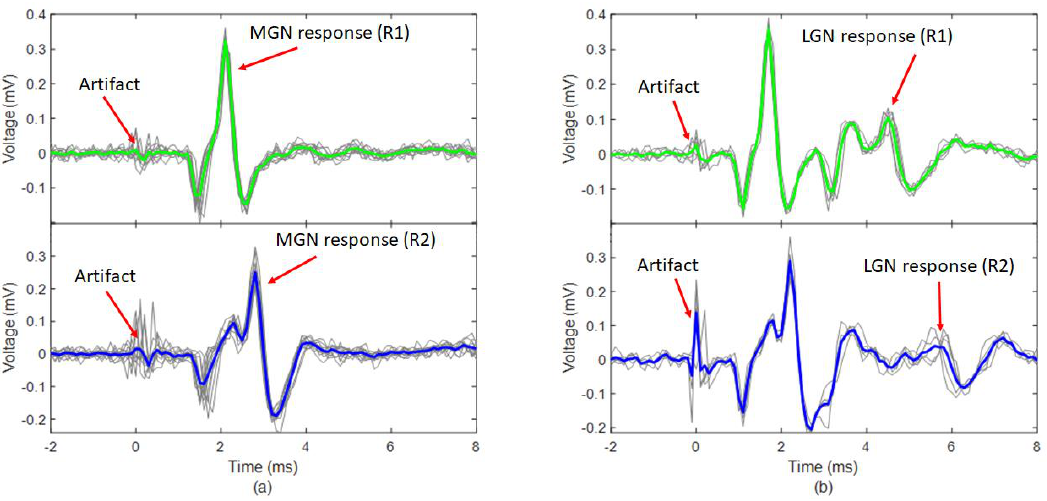
Figure 14. Nerve spikes in response to monophasic current stimulation of a 100 µ s duration recorded from R1 and R2 with amplitude swept from ( a ) 200 to 650 µ A and ( b ) 700 µ A to 2 mA. Recordings were made using a commercial recording unit Neuron SpikerBox Pro (Backyard Brains, Ann Arbor, MI,